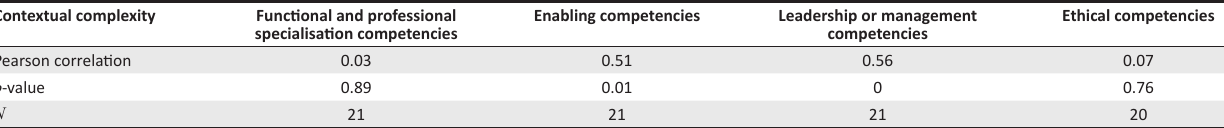
TABLE 4: Inter-correlations of contextual complexity amongst the four competency